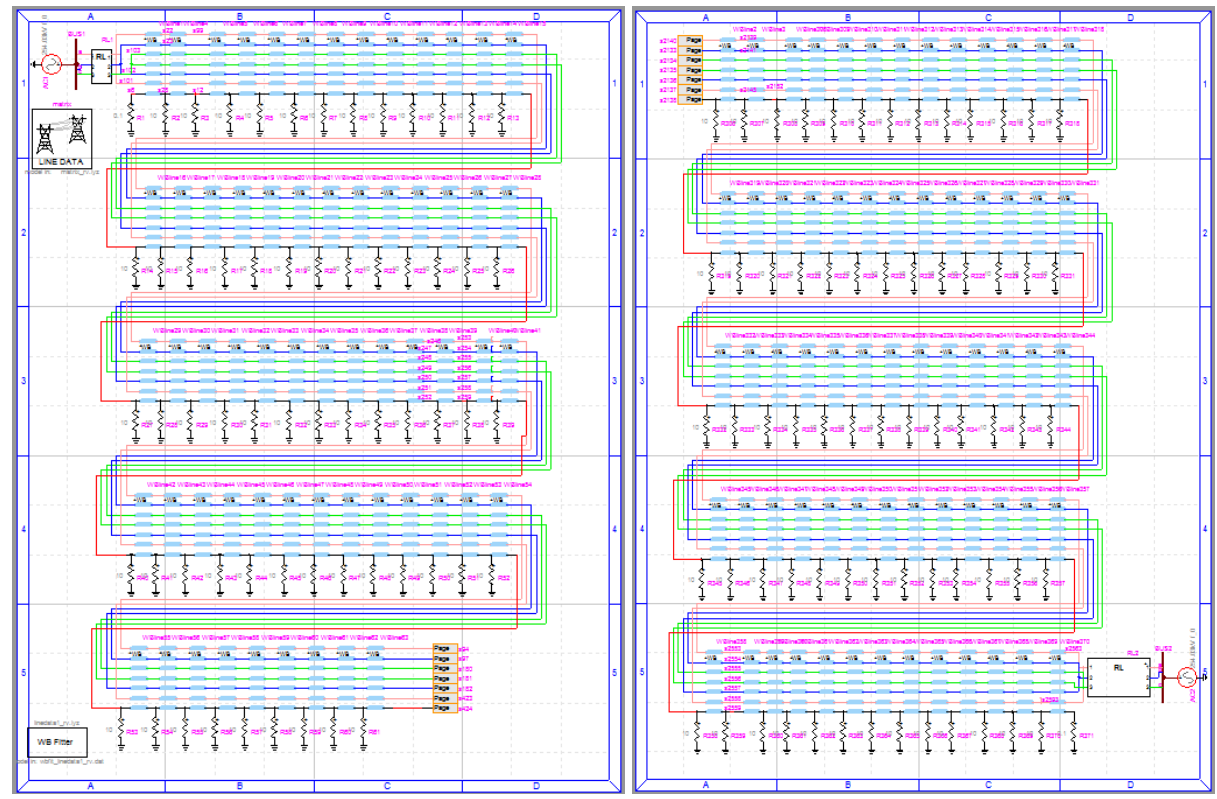
Figure 19. Ground return current magnitude | I